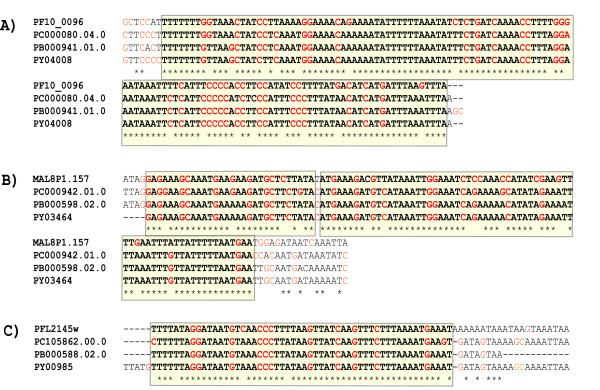
Downstream blocks conserved beyond neutralexpectations among P. falciparum and the three mouse malaria species. The blocks are located (A) at 172 bps downstream of PF10_0096, a hypothetical gene, (B) at 108 bps downstream of MAL8P1.157, a hypothetical gene, and (C) at 140 bps downstream of PFL2145w, a hypothetical gene. 15 conserved blocks in downstream regions had a p-value of 10-6 or lower.